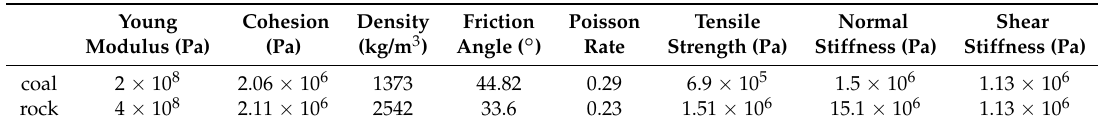
Table 2. Particle material properties of the